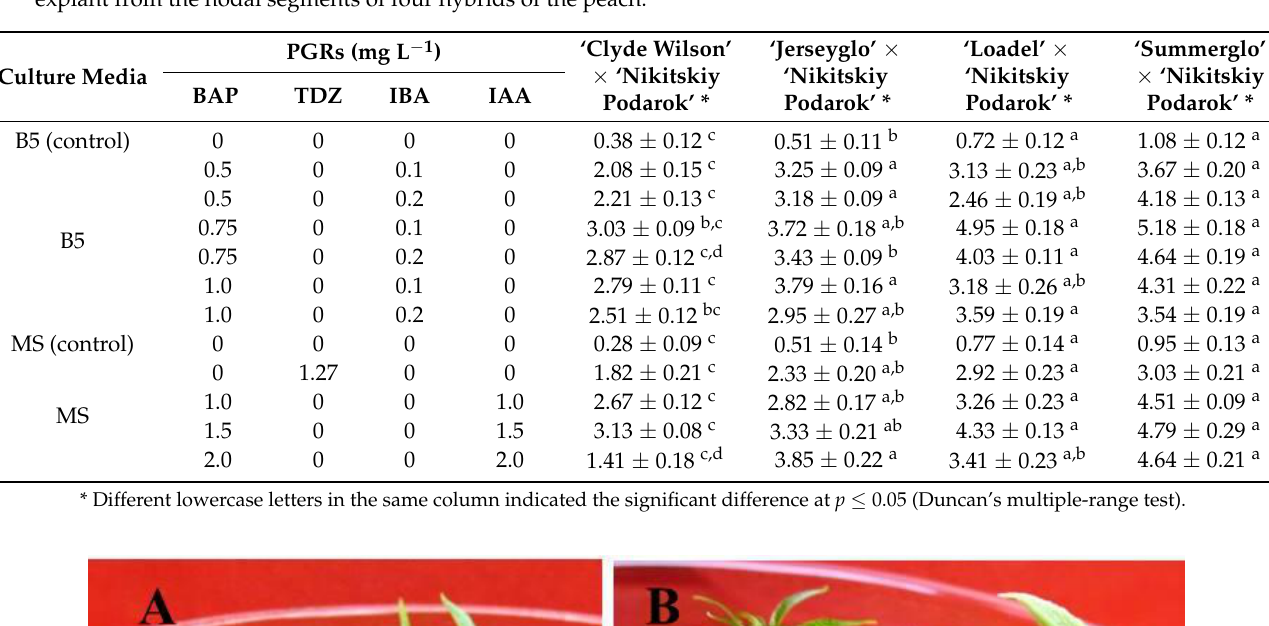
Table 3. Effect of the culture media, different plant growth regulators and their concentrations on the shoot formation per explant from the nodal segments of four hybrids of the peach.